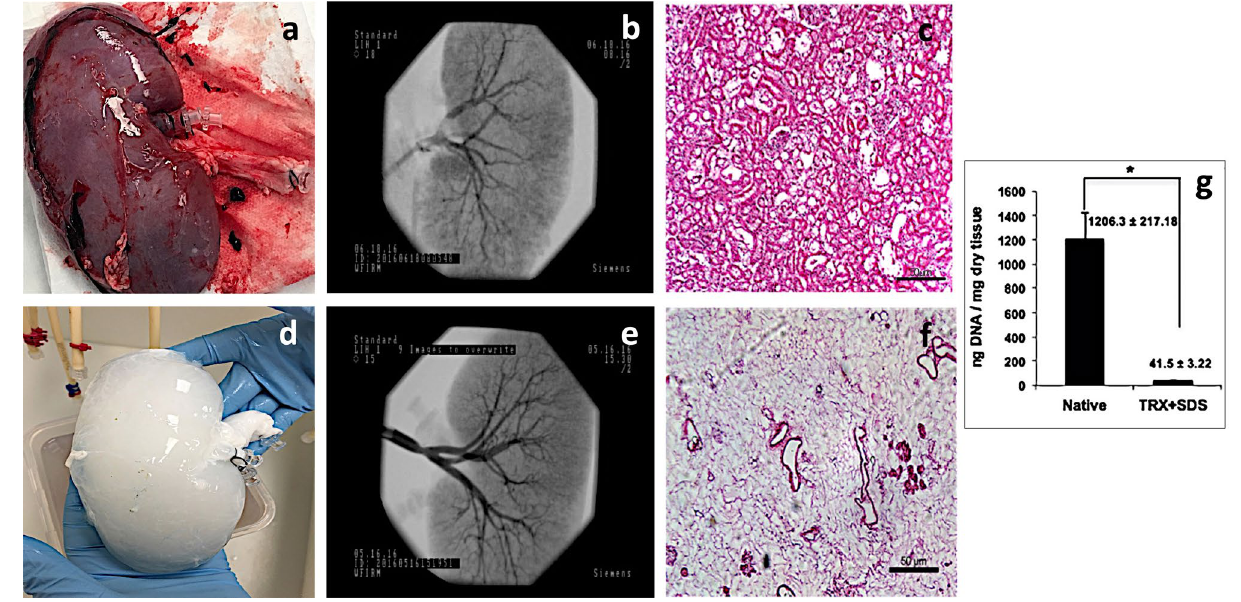
Figure 1. Perfusion decellularization of whole porcine kidneys. A photograph ( a ), angiographic analysis ( b ), and histologic analysis (H&E) ( c ) of the native kidney. A photograph ( d ), angiographic analysis ( e ), and histologic analysis (H&E) ( f ) of the decellularized native kidney. DNA quantification for native and decellularized kidneys ( g ). Images ( c ), ( f ) and ( g ) are reprinted from Acta Biomaterialia, Volume 75, Zambon,